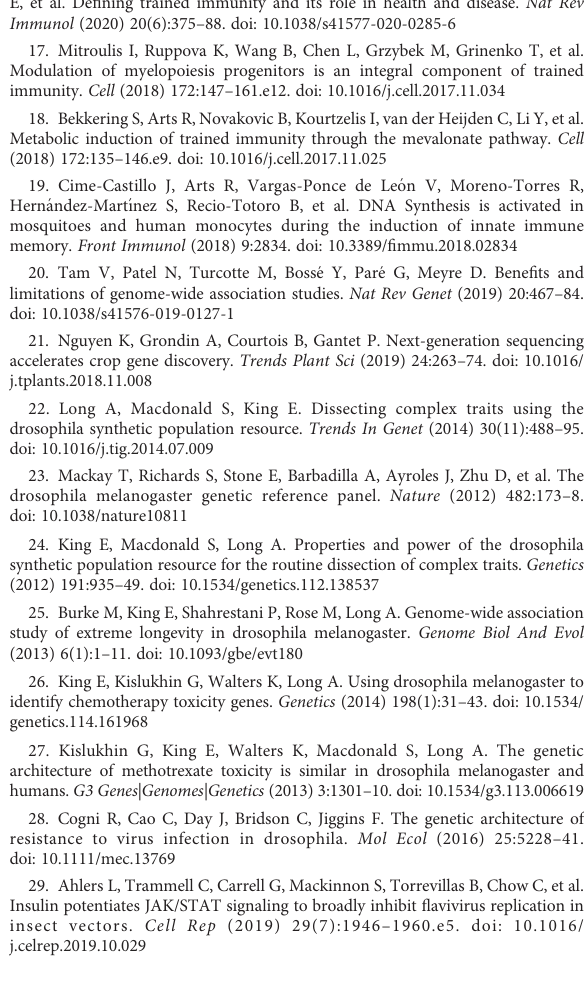
survival rate, hazard ratio (HR), and normalized HR are listed at each time point after Sa